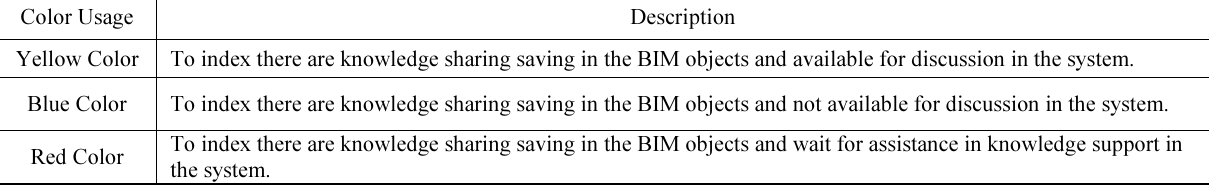
Table 1. The application of color usage in BIM module